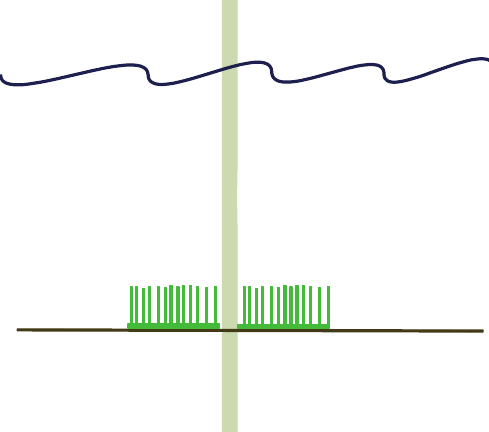
Figure 1: Illustration of polypropylene fronds designed as scour protection around monopile o ff shore wind